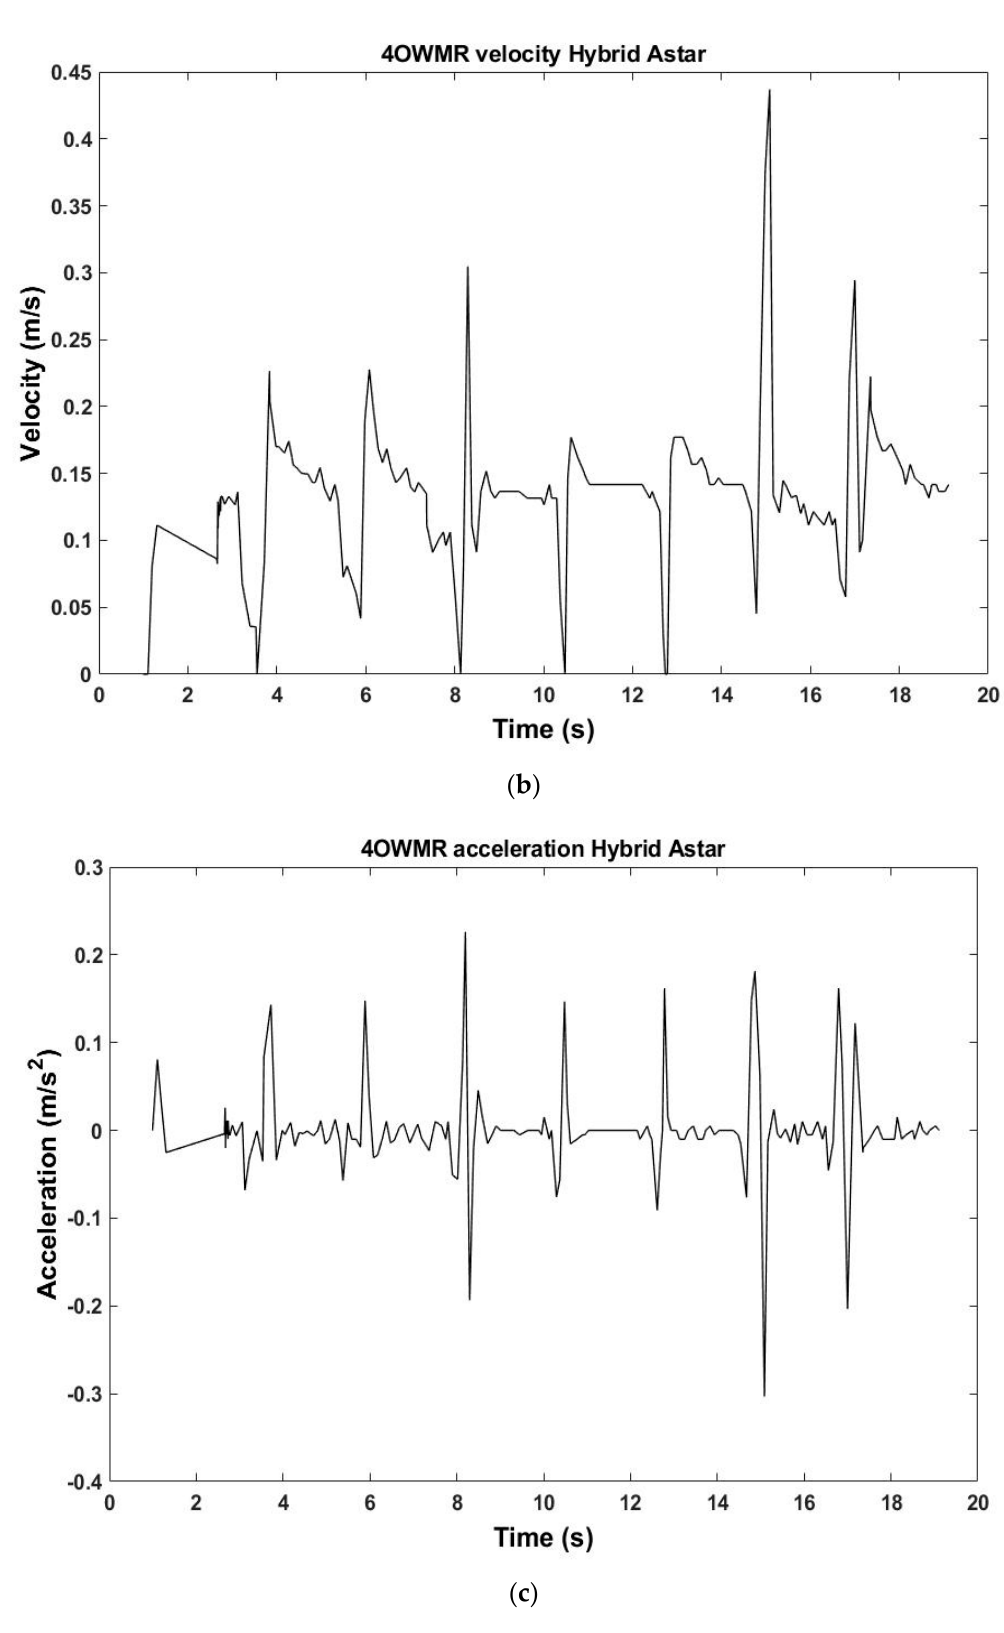
Figure 16. ( a ) The velocity reading of each wheel of the 4OWMR during Hybrid A* implementation for Map3. ( b ) The velocity of the 4OWMR during Hybrid A* implementation for Map3. ( c ) The acceleration of the 4OWMR during Hybrid A* implementation for Map3.